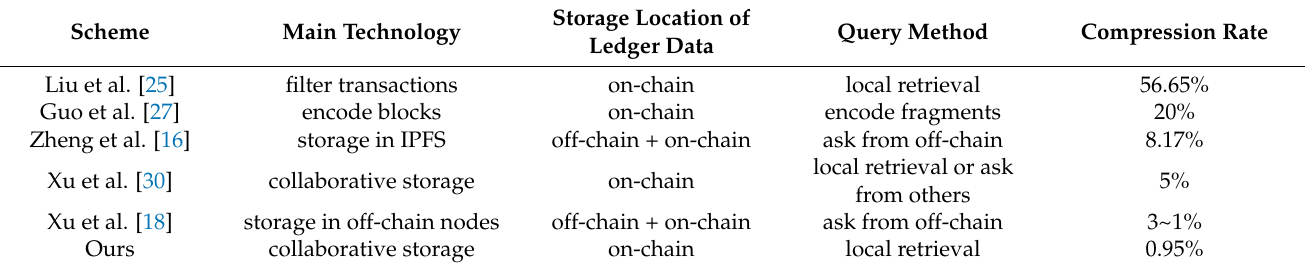
Table 1. Comparison of CBCS and the related